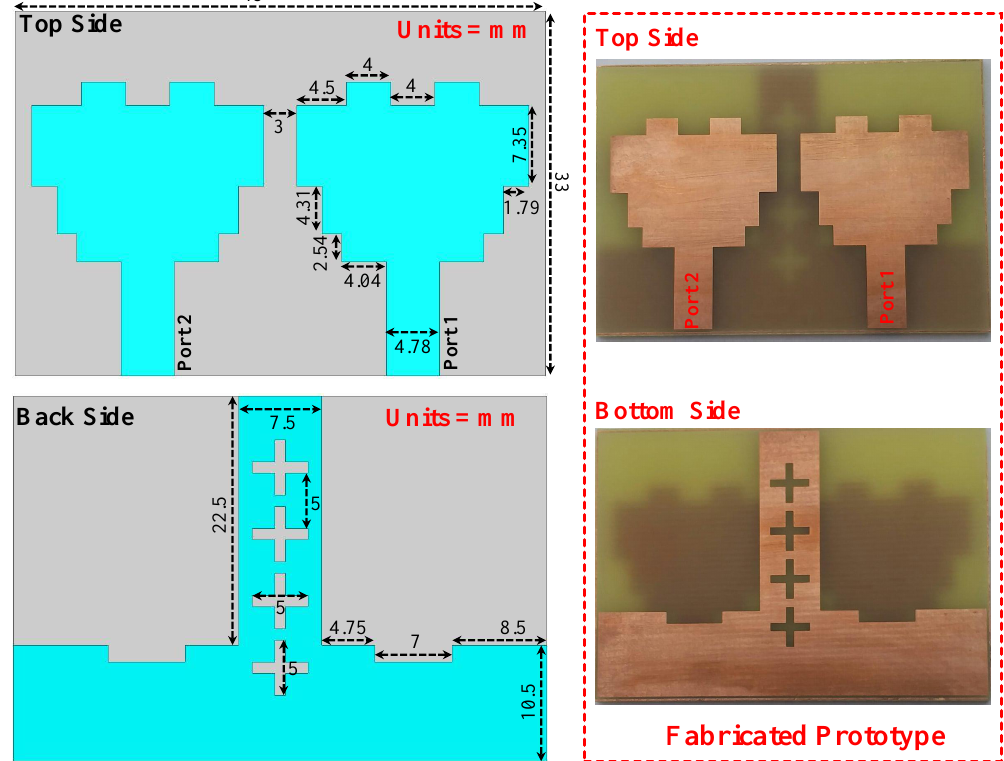
Figure 1. Top and bottom view of the proposed ultra wide-band multiple input multiple output (UWB-MIMO)